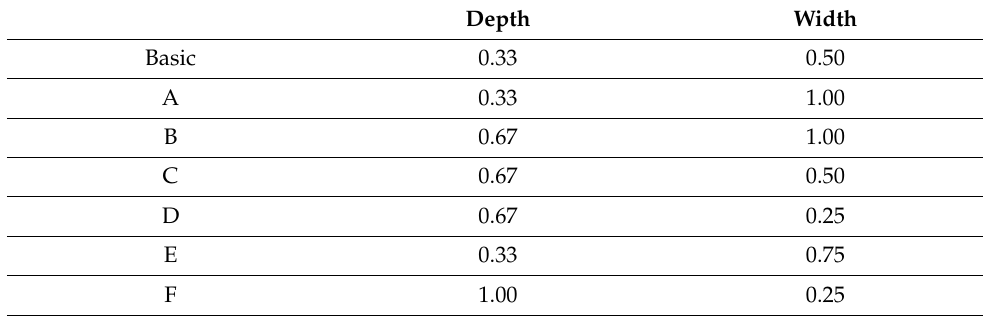
Figure 15. Result graph (model scaling). To analyze the trend of model performance that is revealed through the change in pruning value and find the suitable model, 4 cases of pruning values — 10%, 30%, 50%, and 70% — were analyzed. Figure 16 shows the graph summarizing the results of the four cases. When the pruning values were 10%, 30%, 50%, and 70%, mAP values were approximately 95%,